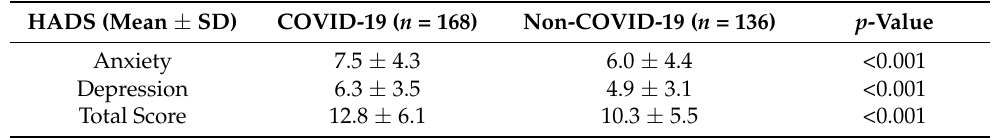
Table 3. HADS questionnaire results between COVID-19 positive and negative pregnant